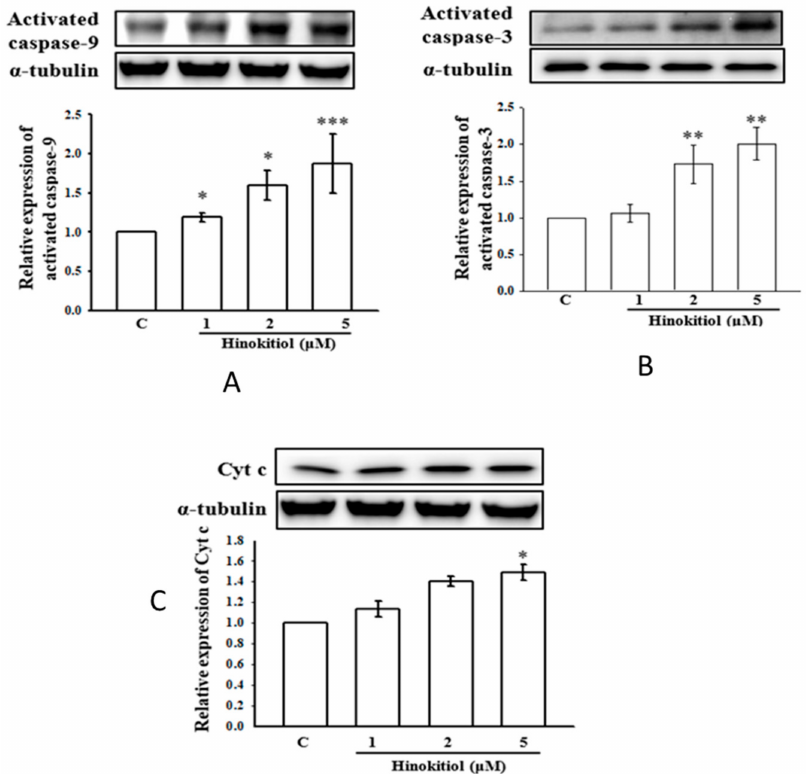
Figure 3. Effect of hinokitiol on caspases activation and cytochrome c release. ( A , B ) Relative concentration-dependent activation of activated caspase-9 and -3 in A549 cells treated with various concentrations of hinokitil. Caspase-9 ( A ) was activated in a concentration (1–5 µ M) dependent manner, whereas caspase-3 ( B ) was induced significantly only at 2 and 5 µ M. ( C ) Meanwhile, cytochrome c was released at the higher concentration (5 µ M) of hinokitiol treatment. The data represent the means ± SEM of three independent experiments. * p < 0.05, ** p < 0.01, and *** p < 0.001 compared with untreated A549